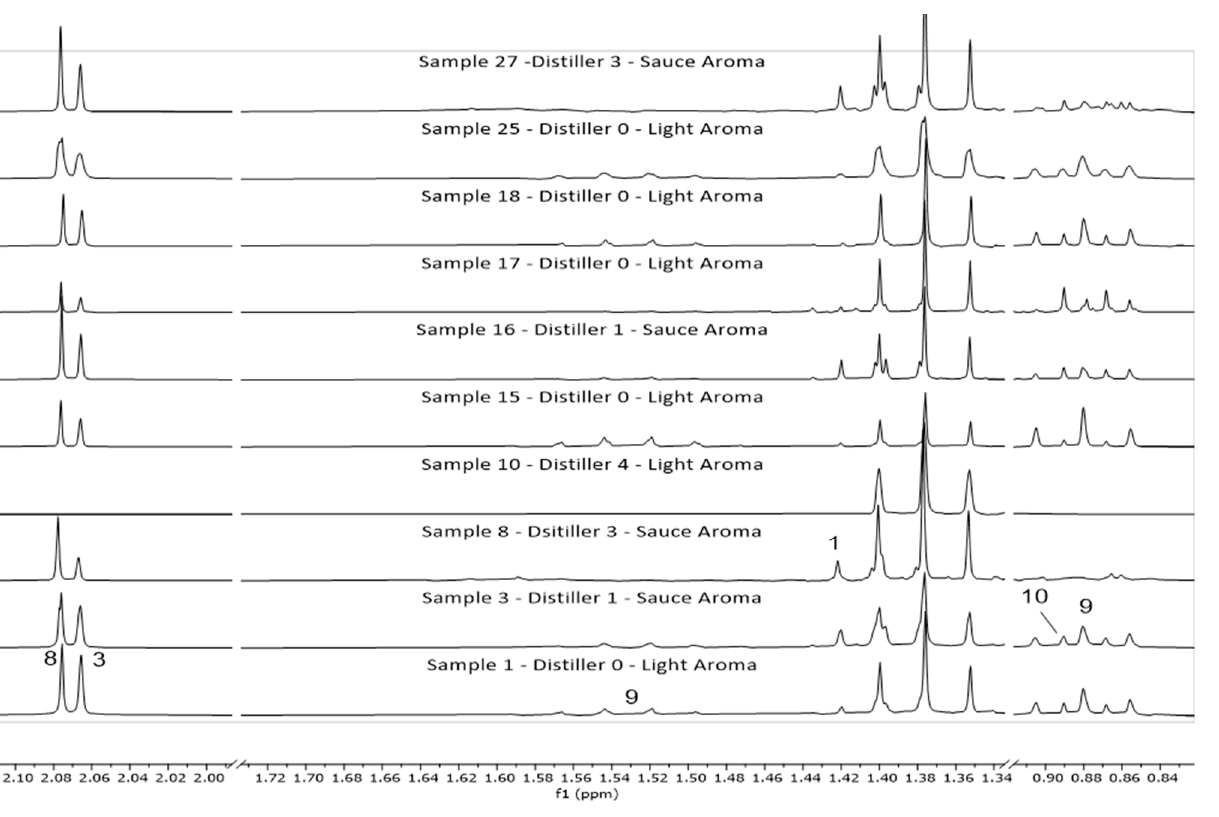
Figure 5. 1 H NMR—methyl region—stacked plot comparisons of 10 of 30 baijiu samples analyzed in this study. Sample 10 stands out as a potential counterfeit sample, as it only shows the presence of ethanol. No congeners are observed, as in the other samples. The numbered assignments are as follows: 1. lactic acid, 3. ethyl acetate, 8. acetic acid, 9. 1-propanol, 10. isopentanol.